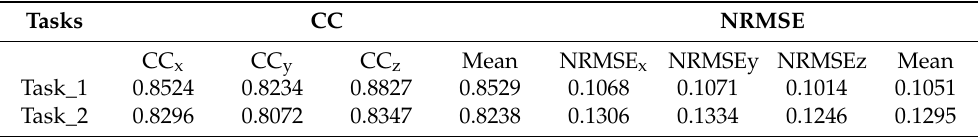
Table 3. The performance of intention prediction for quick movement in 3-D (x, y, z). Tasks